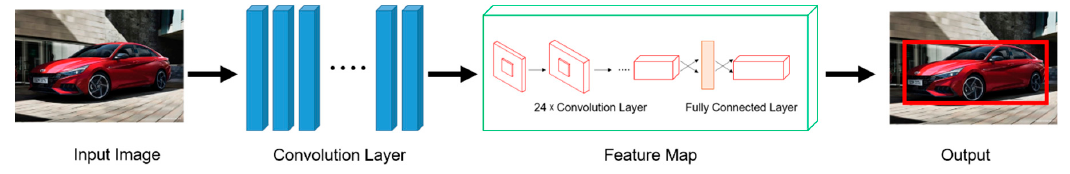
Figure 1. Image object detection process.